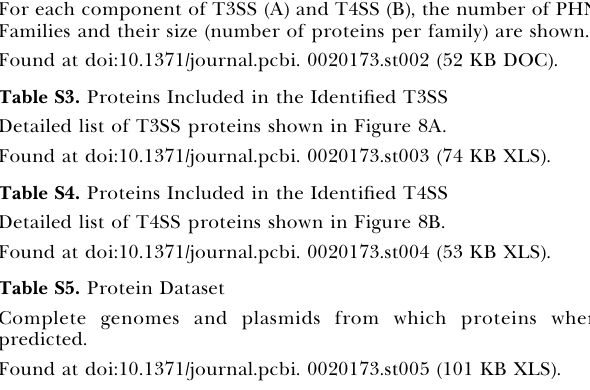
Table S2. T3SS and T4SS PHN-Families